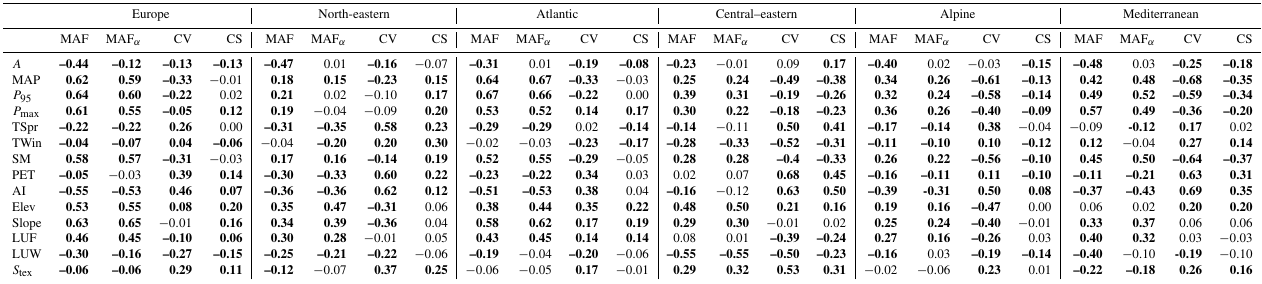
Table A5. Spearman correlation between statistical moments of flood series, including mean specific discharge MAF, mean specific discharge normalized to a catchment area MAF α of α = 100km 2 , the coefficient of variation CV, the CS, and catchment attributes. Statistically significant estimates (at the 5% level) are printed in bold.